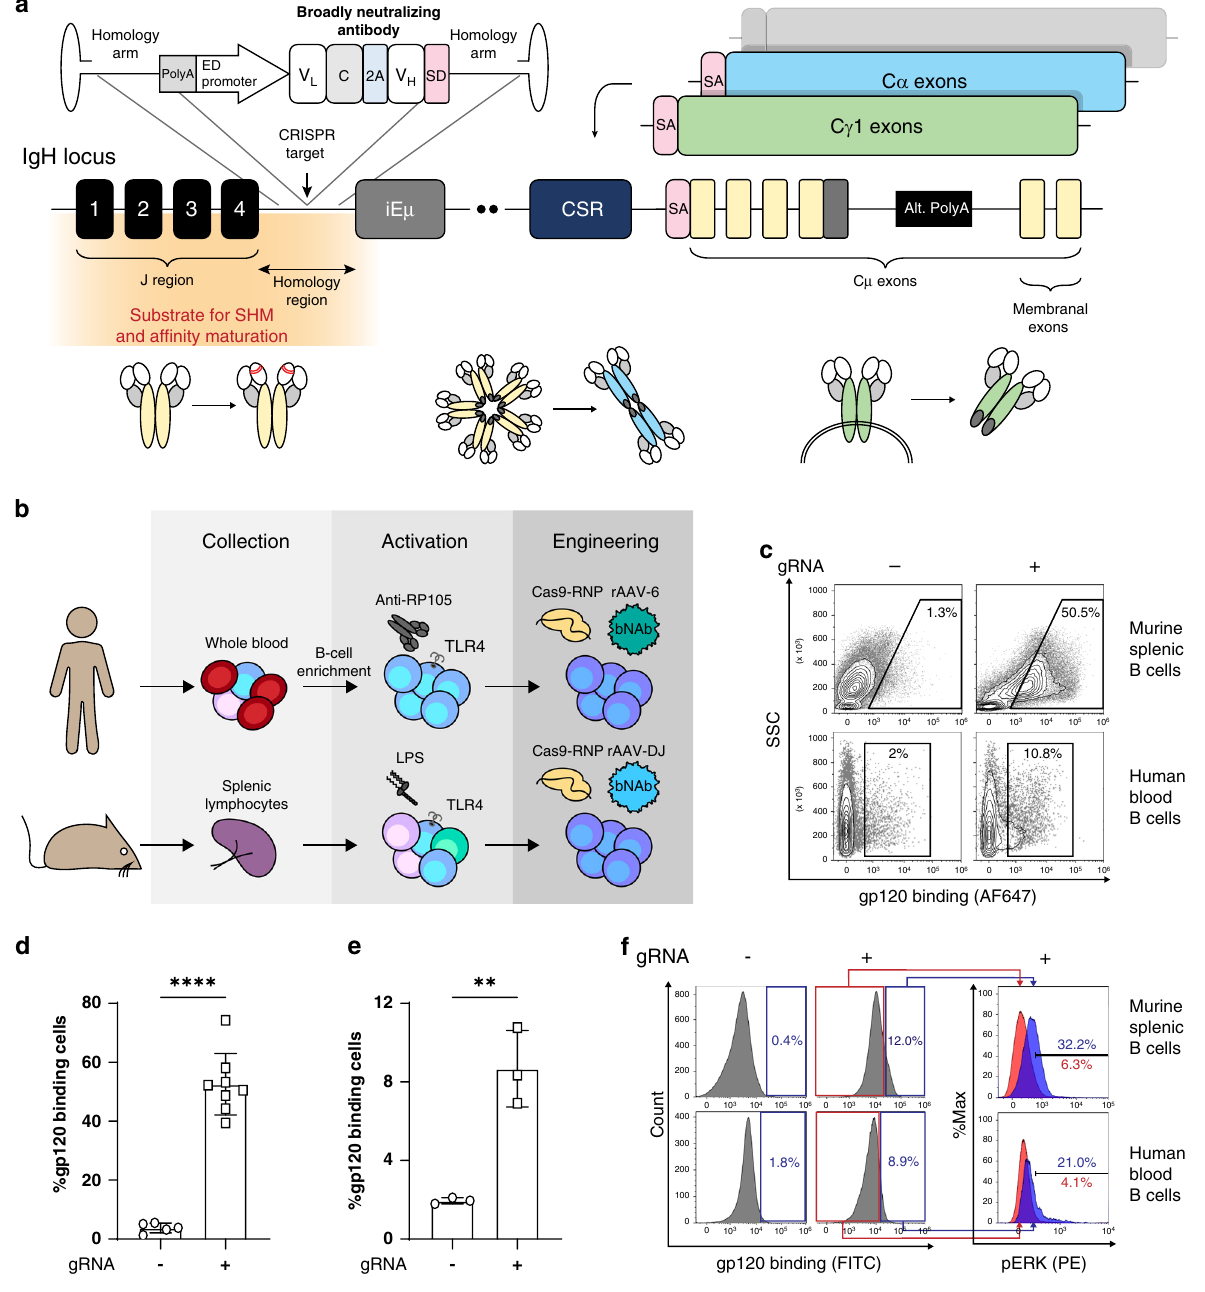
Fig. 1 Engineering B cells to express an anti-HIV bNAb. a Targeting scheme. An rAAV-delivered cassette is targeted to the J-C intron of the IgH locus using CRISPR/Cas9. The bicistronic cassette encodes the light and heavy chains of the 3BNC117 anti-HIV bNAb, under the control of an enhancer dependent (ED) promoter. Splicing with endogenous constant segments allows the expression of a BCR and differentiation into memory B cells and Ig secreting plasma cells upon subsequent antigen-induced activation and alternative polyadenylation (Alt. PolyA). Targeting the J-C intron upstream of the intronic enhancer (iE μ ) and switch region further facilitates CSR and SHM. See also Supplementary Fig. 1. b Activation and engineering scheme. Human B cells are collected from blood samples, activated using an anti-RP105 (TLR4 homolog) antibody, electroporated by CRISPR/Cas9 RNP and transduced using rAAV-6. Splenic B cells are activated using the TLR4 agonist LPS electroporated by CRISPR/Cas9 RNP and transduced using rAAV-DJ. c Flow cytometry plots measuring binding of the HIV gp120 antigen by the 3BNC117 BCR following activation and engineering of primary cells. Cells transduced with the donor rAAV and without gRNA serve as a negative control, gating on live, singlets. d , e Quanti fi cation of C for mouse ( n = 5 for – gRNA and n = 8 for + gRNA, each dot represents a biologically independent sample, data represented as mean values + / − SD) d and human ( n = 3, each dot represents a biologically independent sample, data represented as mean values + / − SD) e primary cells. **** p < 0.0001, ** p = 0.0040; two-tailed t -test. f Flow cytometry plots demonstrating ERK phosphorylation in primary mouse or human B cells engineered with 3BNC117 and in vitro activated with the gp120 antigen of the YU2.DG HIV strain, gating on